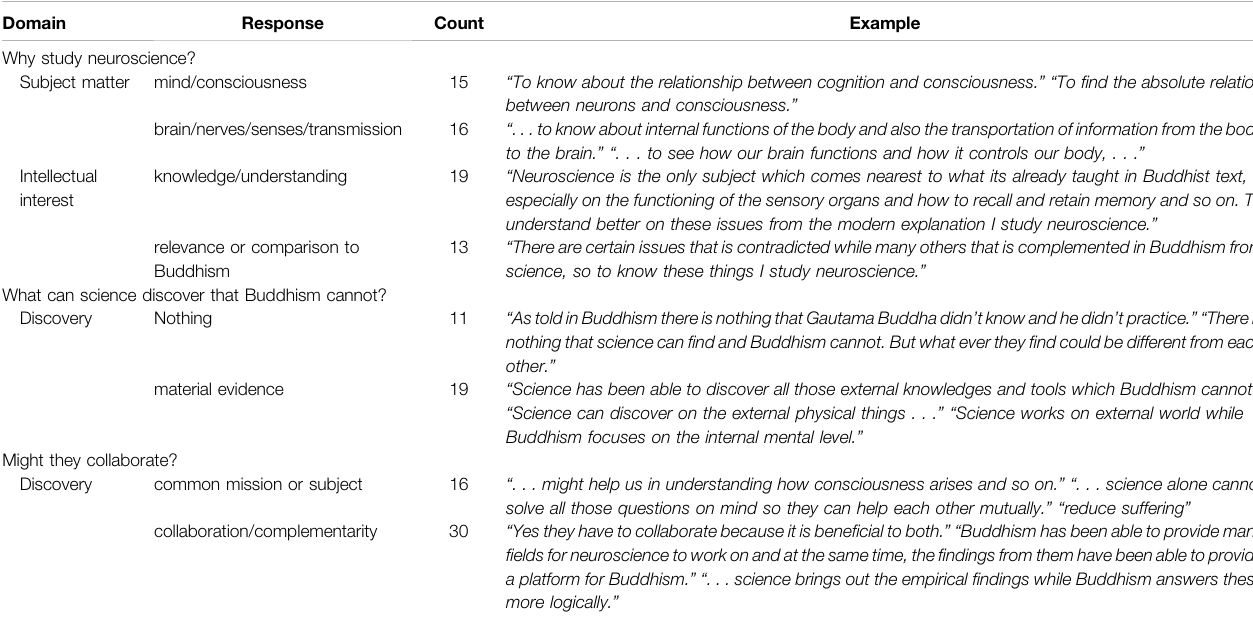
TABLE 1 | Initial attitudes about engaging with science, particularly neuroscience. Frequencies represent a count of responses that used a related word or concept (n of respondents =